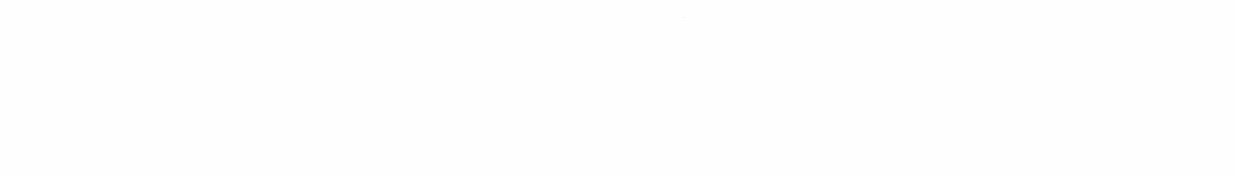
Fig. 6. Effect of varying the preincubation period [immediate (above); overnight (below)] prior to LPS induction of IL-6 mRNA in human cytotrophoblast cells. Note that the 8-h time point is missing in the top